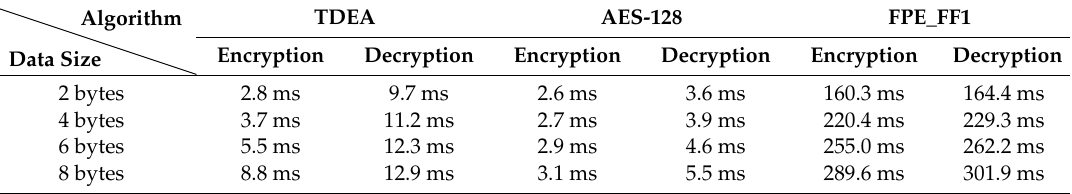
Table 6. Encryption / decryption time comparison using Raspberry Pi (1